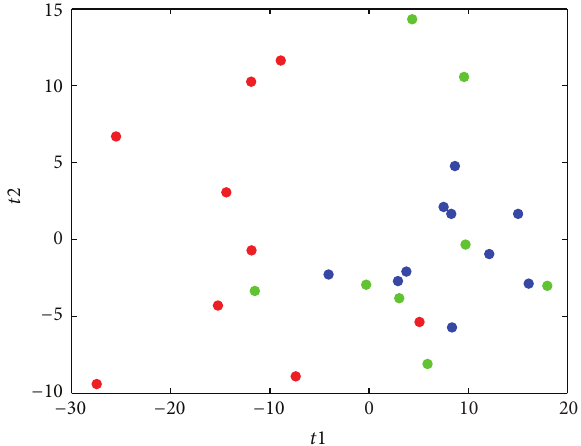
Figure 3: PCA score plot of NMR data from three stages (stage I: red dots; stage II: blue dots; stage III: green